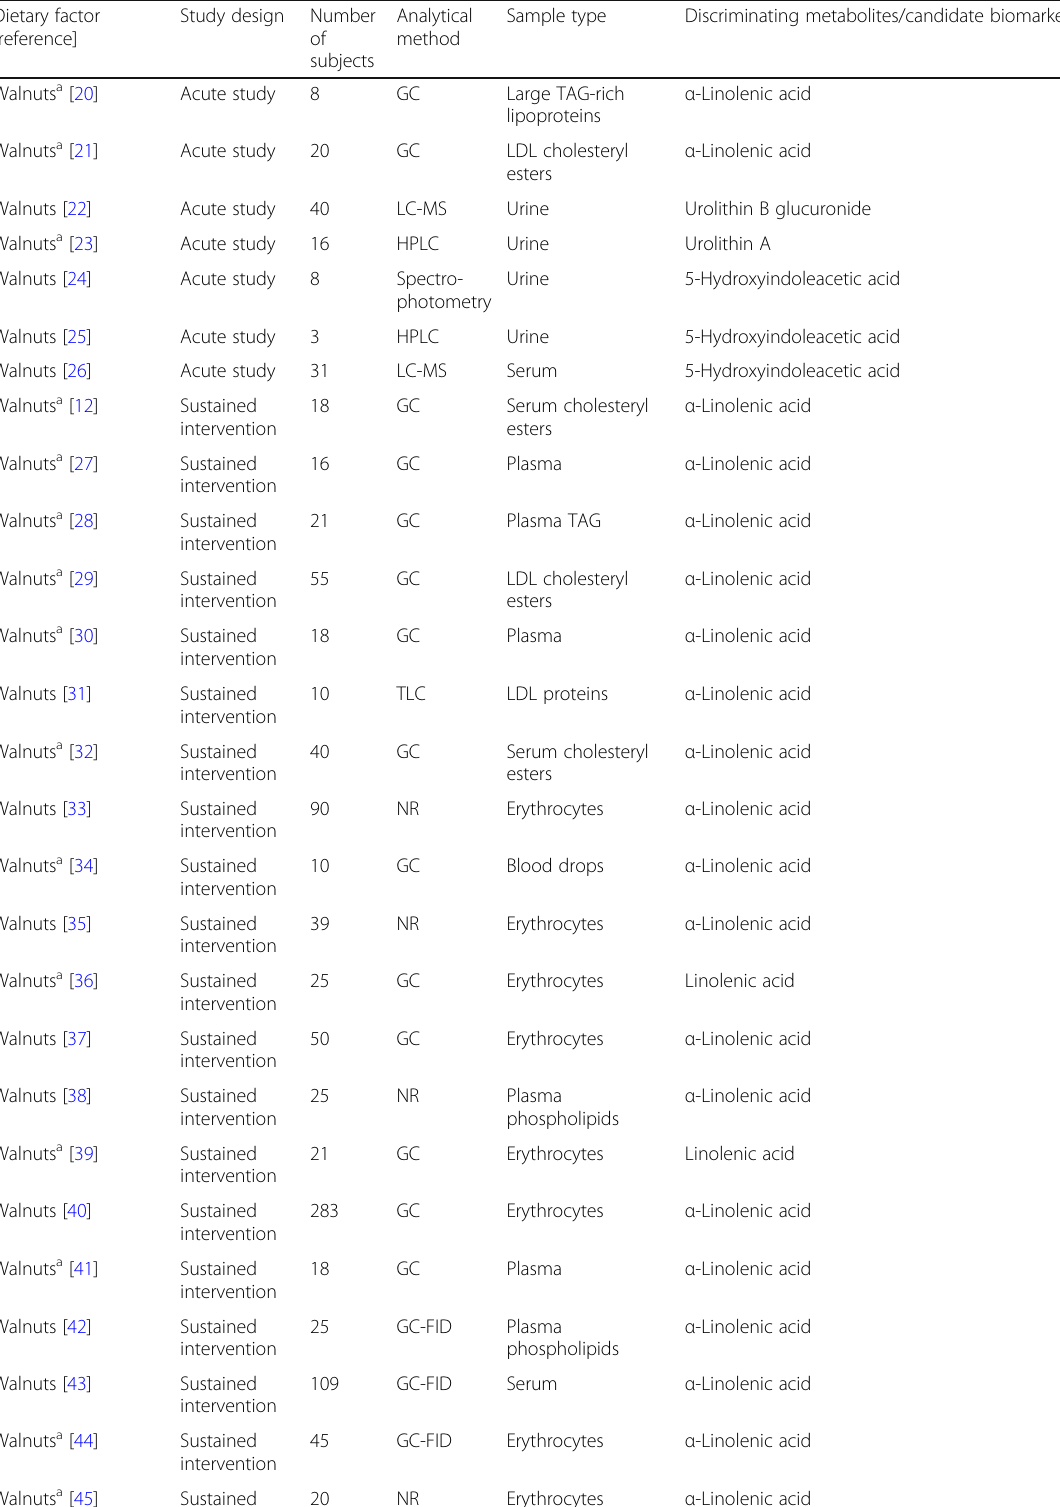
Table 1 Studies reporting associations between consumption and potential candidate food intake biomarkers for nuts Dietary factor